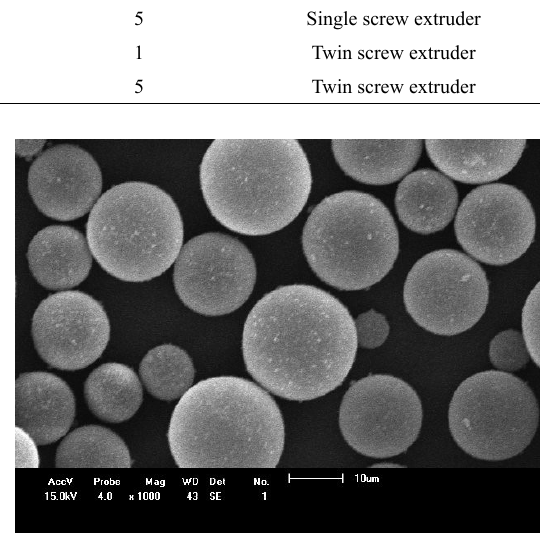
Figure 1. iM16K-type HGM